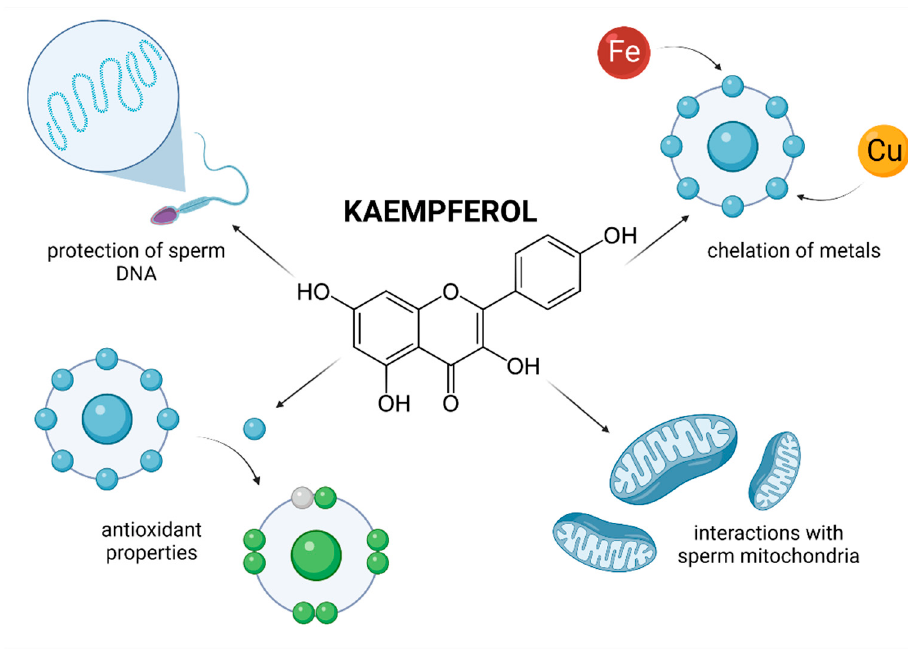
Figure 10. Most frequently reported beneficial effects of kaempferol on spermatogenesis, sperm structural integrity and functional activity. structural integrity and functional